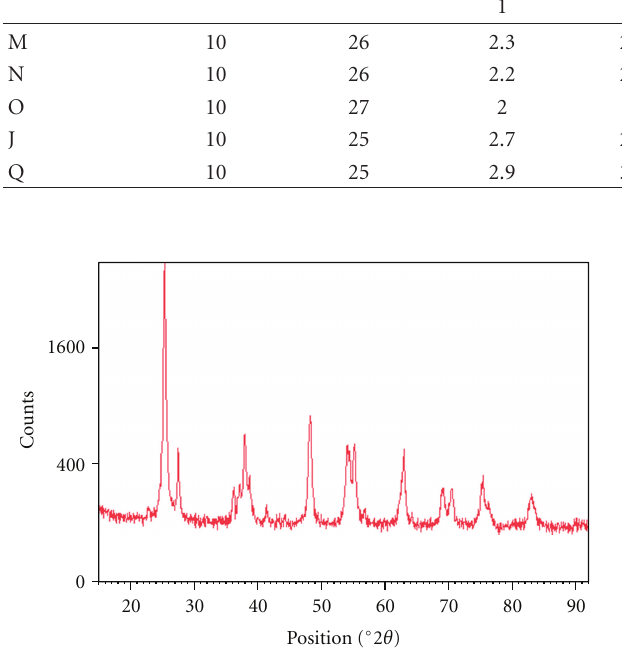
Figure 6: X-ray di ff raction pattern of the TiO 2 photocatalyst.